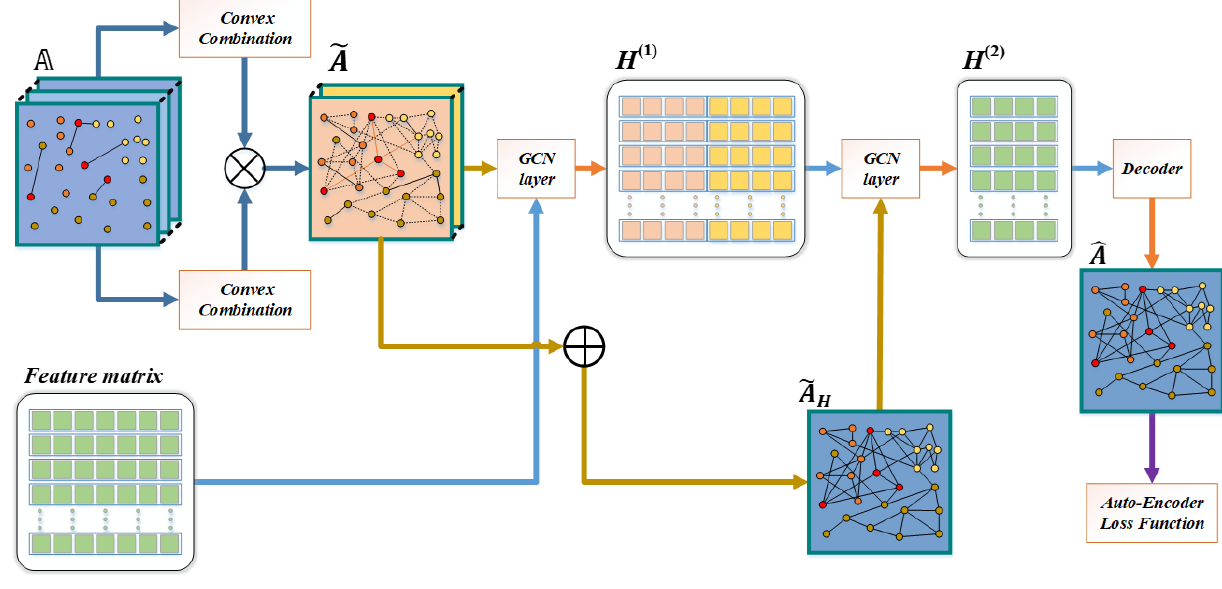
Figure 4. Graph transformer network-based auto-encoder